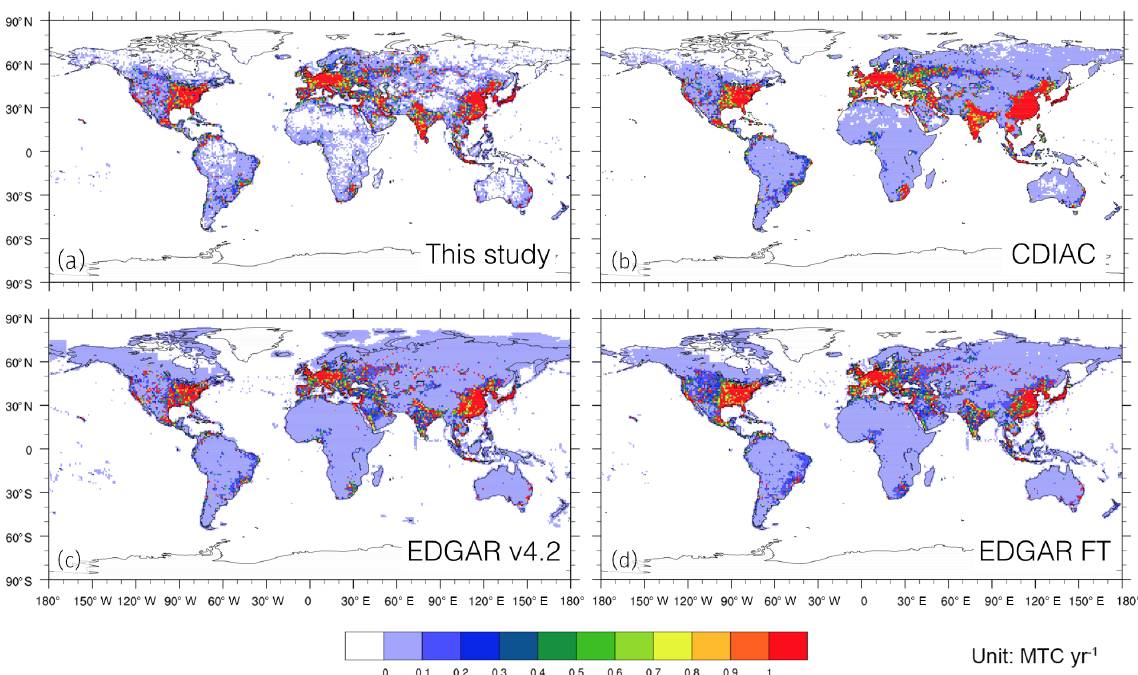
Figure 6. Land emissions from ODIAC (a) , CDIAC (b) , and two versions of EDGAR emissions data (v4.2, c ; and v4.2 FastTrack, d ). The units are million tons of carbon per year per cell (1 × 1 ◦ ). In addition to excluding emissions from international aviation and marine bunkers, some of the sector emissions were subtracted from EDGAR short cycle total emissions to account for the differences in emissions calculation methods between CDIAC and EDGAR. The emissions fields for the year 2008 were used.